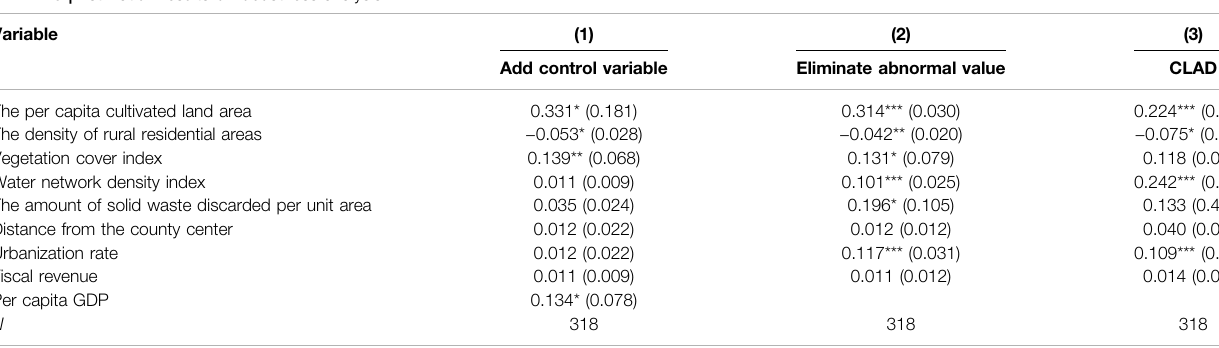
TABLE 5 | Estimation results of robustness